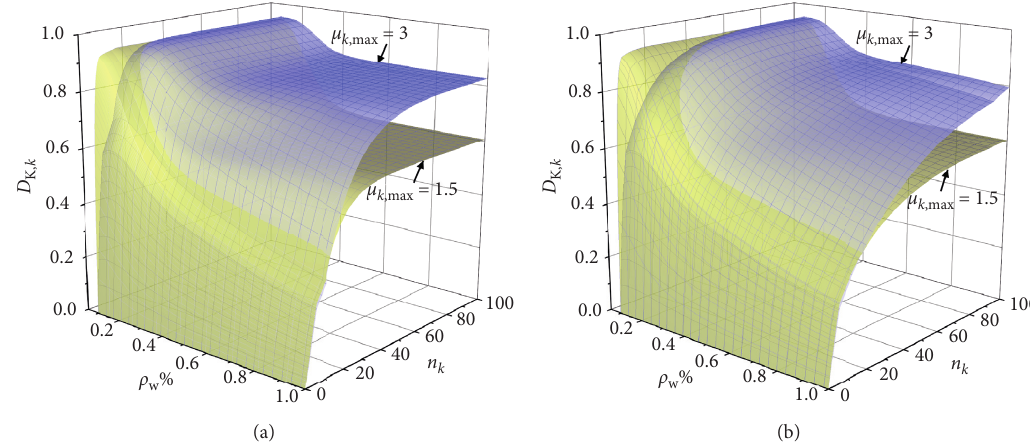
Figure 19: Correlation between D K, k and different parameters. (a) Peak displacement occurs at the front of the displacement history. (b) Peak displacement occurs at the end of the displacement